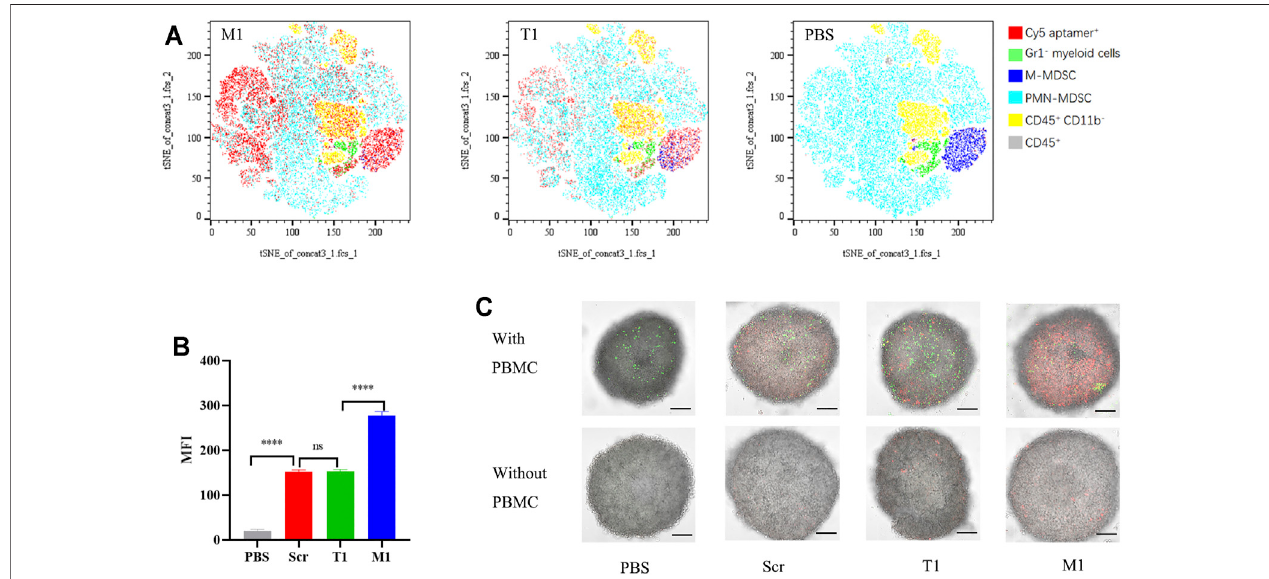
FIGURE4| HighMDSC-bindingcapacityfromtheM1aptamer (A) tSNEmapofT1andM1bindingtoPBMCs exvivo . (B) QuantitativeanalysisofPBMCbindingby aptamers. MFI: median fl uorescence intensity. (C) Images of 4T1 spheroids with cell-transported aptamers. Upper panels: spheroids co-cultured with PBMCs pre- incubated with Cy5-aptamer. Bottom panels: spheroids co-cultured with free Cy5-aptamer. Green dots: CFSE-labeled PBMCs; red dots: Cy5-aptamer. Scale bar: 100 mm.